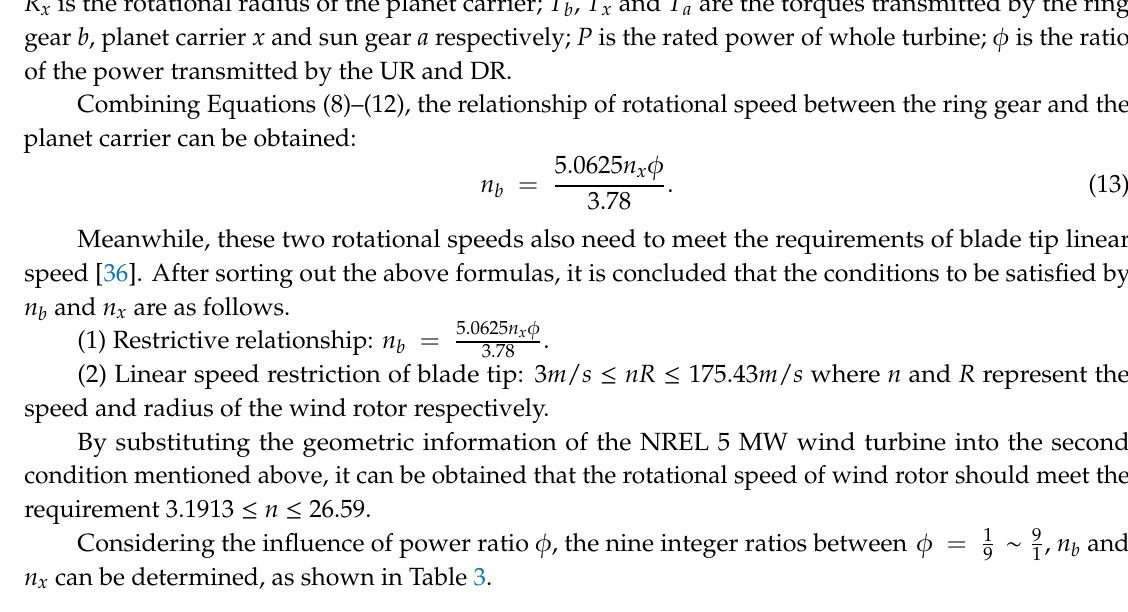
Table 3. Double input rotational speed and power ratios of gearbox of